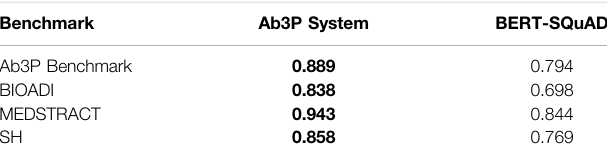
TABLE 3 | Ab3P has better F-scores on four standard benchmarks based on PubMed.